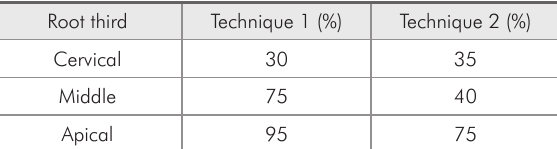
Table 2 - Percentage of residual filling material in each root third based on the technique used to remove the filling material.